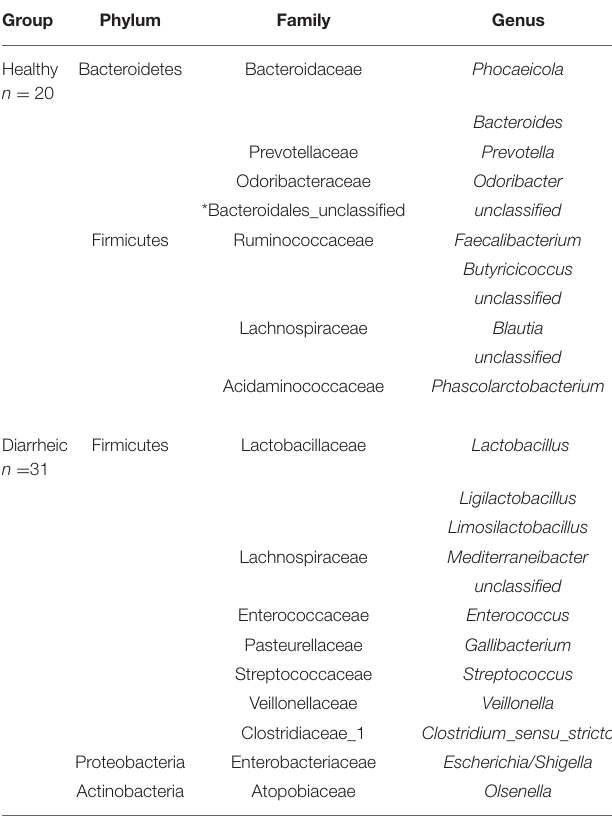
TABLE 2 | Taxa enriched in healthy and diarrheic calves identified using the linear discriminatory analysis (LDA) effect size (LefSe) methodology.